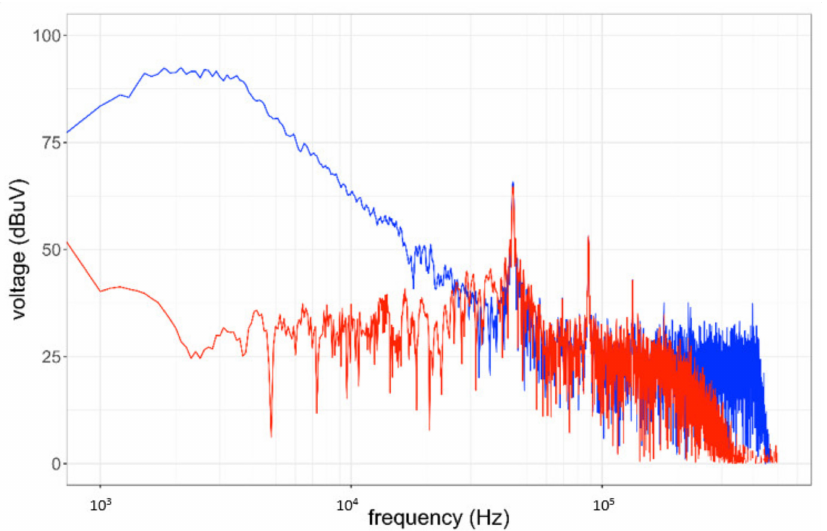
Figure10. ComparisonoftheFFTspectraobtainedfromIMFs2and3extractedwithEMD( red )andfrom the original signal ( blue